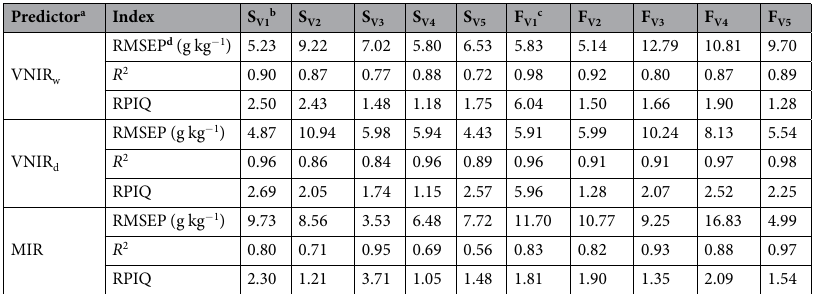
Table 3. Predicted SOC content compared with measured SOC content in each core of the validation sets using SVM. a Predictor used in the models (VNIR w = field-moist intact VNIR spectroscopy; VNIR d = air-dried ground VNIR spectroscopy; MIR = air-dried ground MIR spectroscopy); b ‘S V ’ is the soil cores of validation dataset in the shrub meadow; c ‘F V ’ is the soil cores of validation dataset in the forest; d the unit of RMSEP is g kg − 1 .